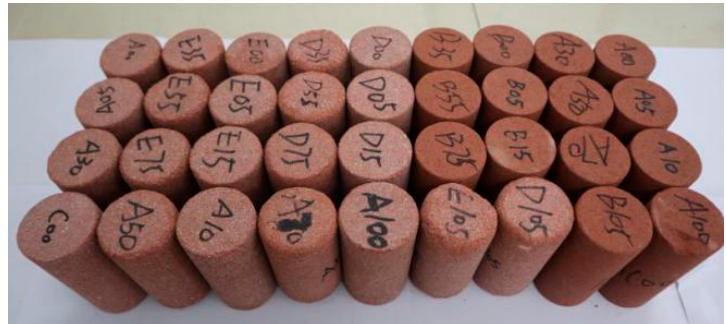
Figure 4. Red sandstone samples.